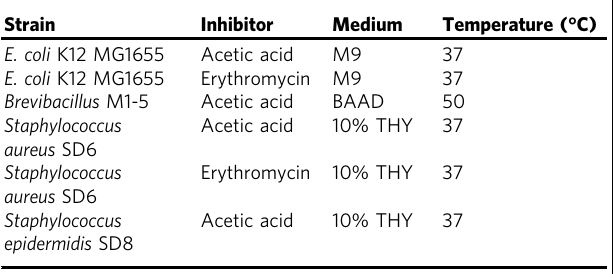
Table 2 Strains and culture conditions for characterizing the inhibitory effects are